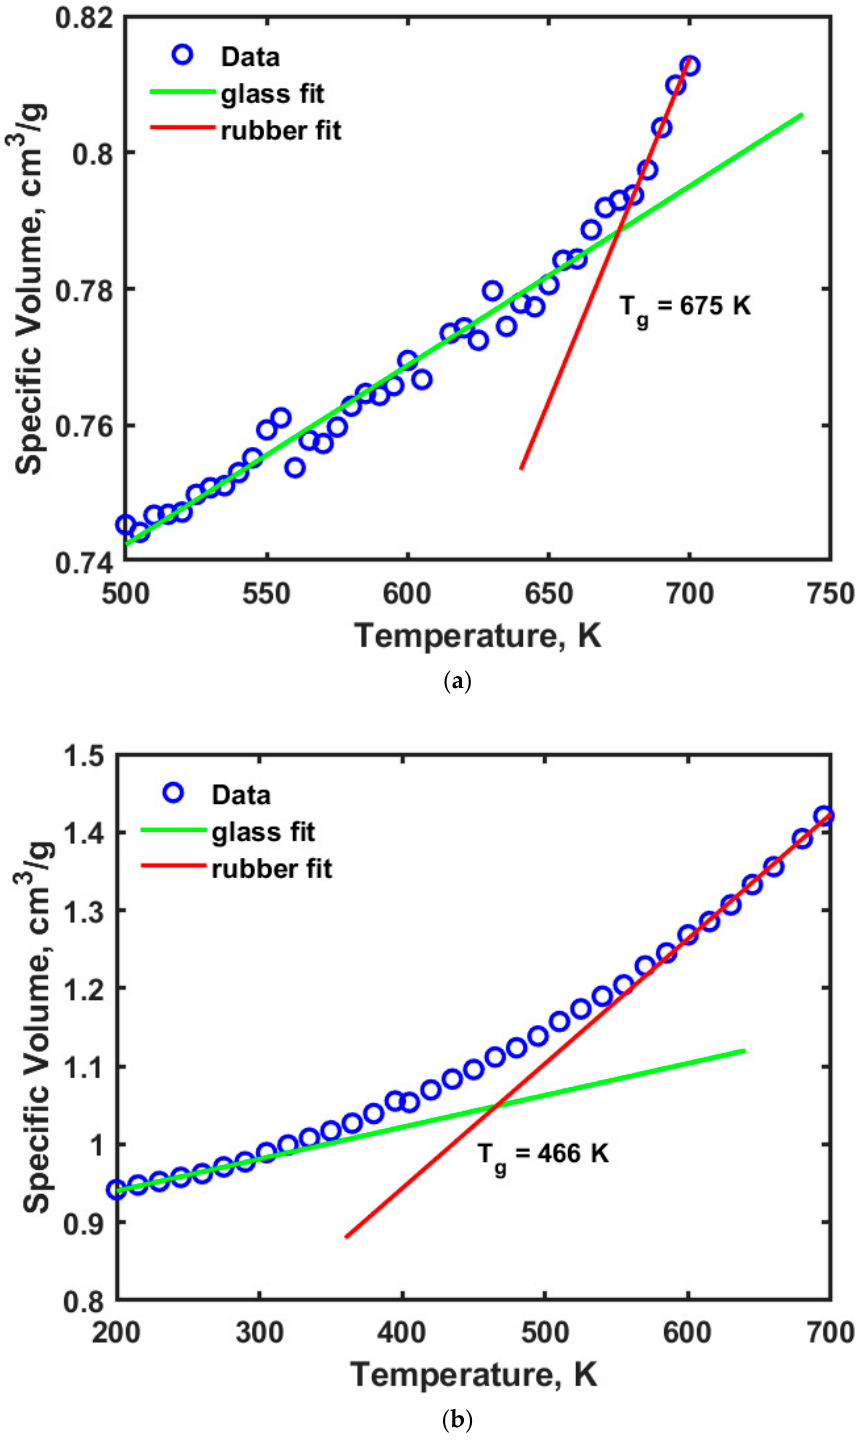
Figure 3. Temperature versus specific volume profiles for ( a ) cellulose ( b ) adulose. In Equation (1), V F is the free volume of the polymer, V O is the volume occupied by the polymer and the sum of V F and V O is the total volume of the polymer. The free volume